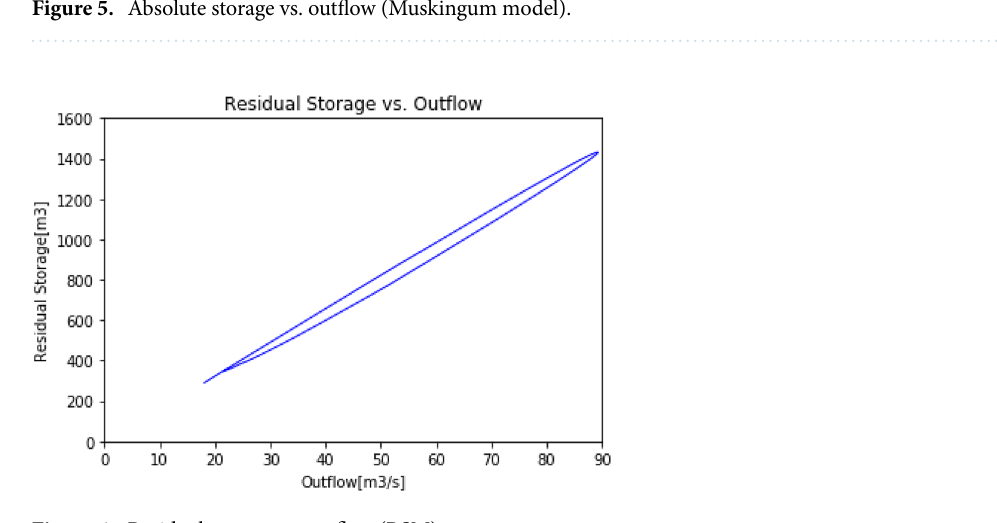
Figure 6. Residual storage vs. outflow